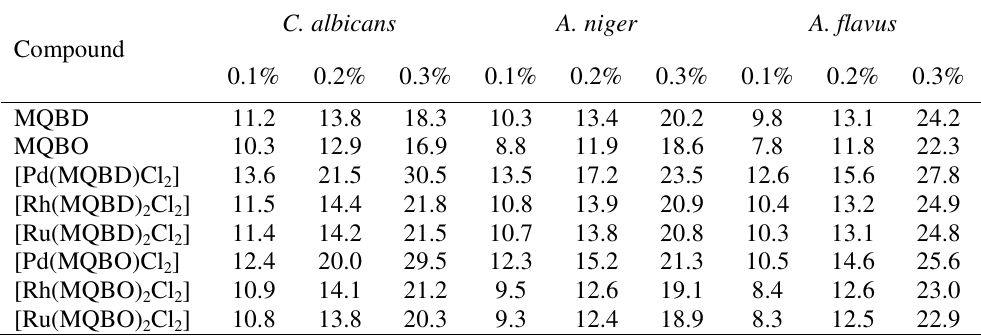
Table 4 . Percentage inhibition of fungicidal